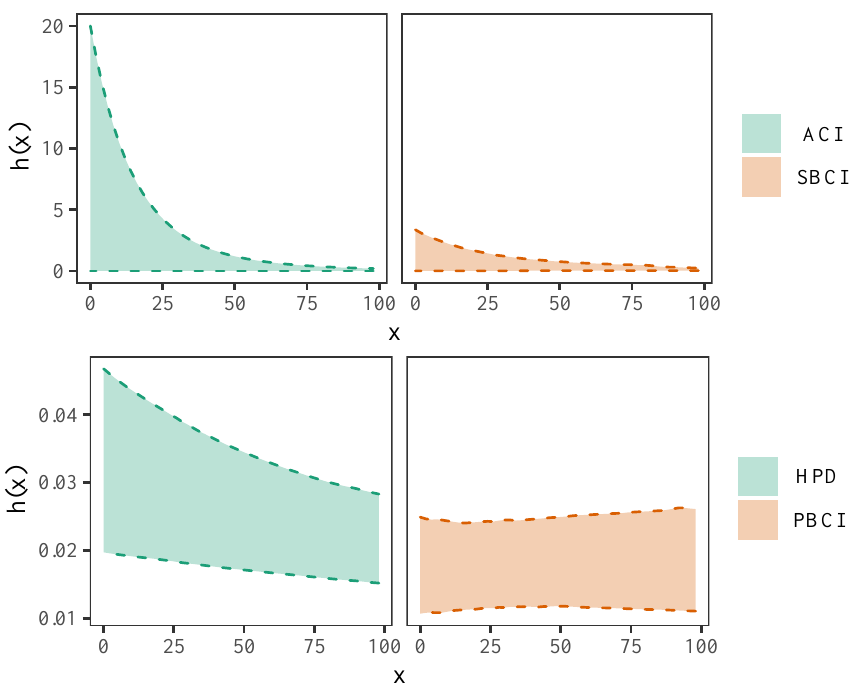
Figure 9. Interval estimates of HRF h ( x ) for the real